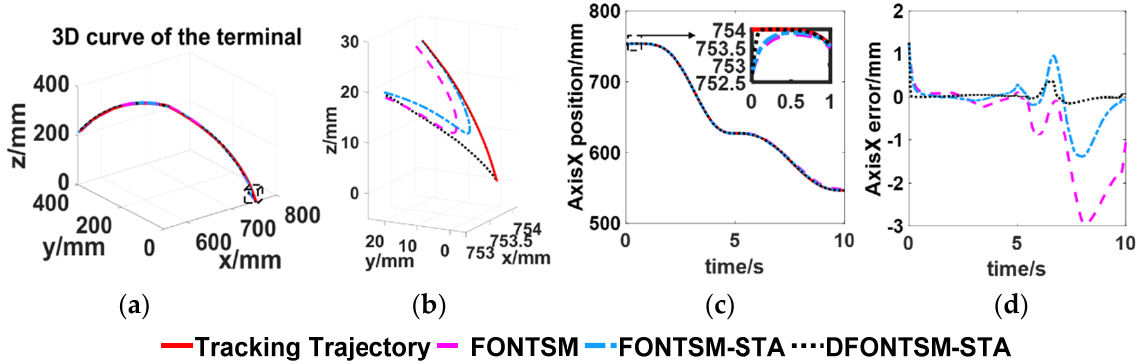
under base coordinate; ( b ): Terminal trajectory tracking error; ( c ): axis X position; ( d ): axis X error.